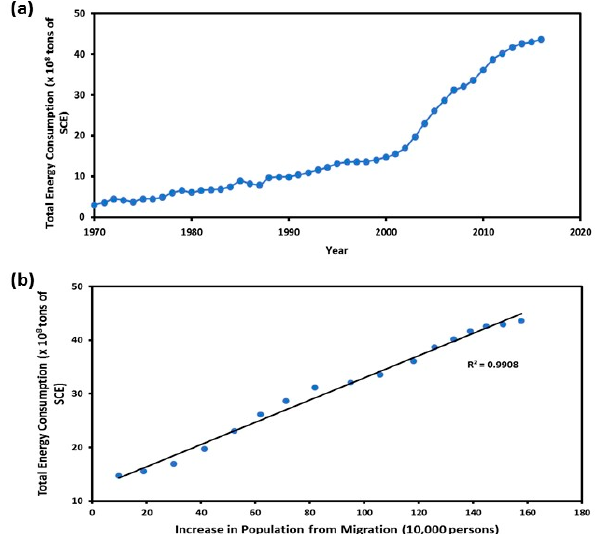
Figure 6. ( a ) The annual energy consumption in Shanghai from 1970 to 2016, ( b ) Relationship between annual energy consumption and net population increase from migration using the 2000 baseline. Data extracted from China Statistical Yearbook 2017 [49].